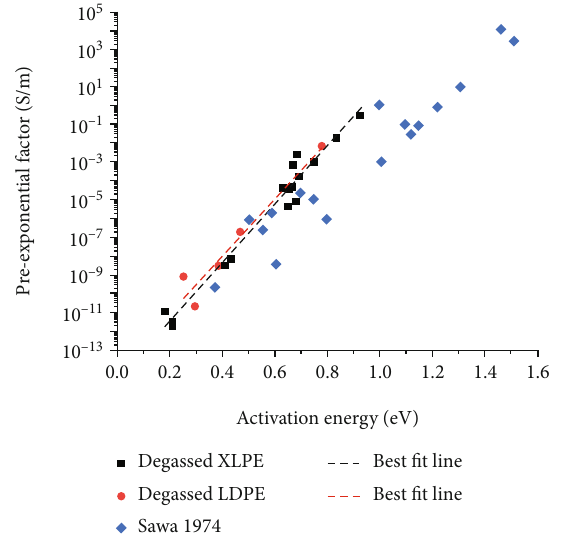
Figure 3: Compensation plot comparing degassed XLPE and degassed LDPE. Comparison LDPE data from the work of Sawa et al. is indicated